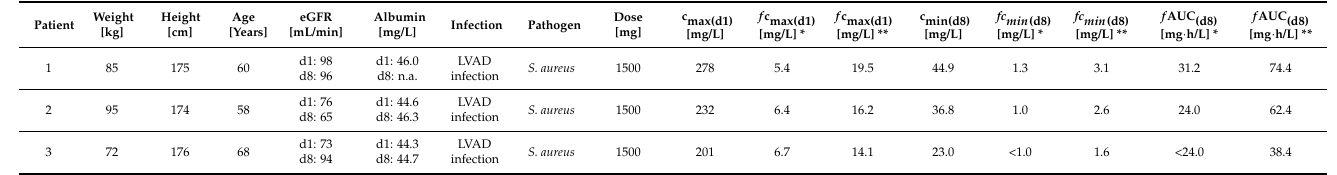
Table 1. Dalbavancin concentrations of three cardiologic